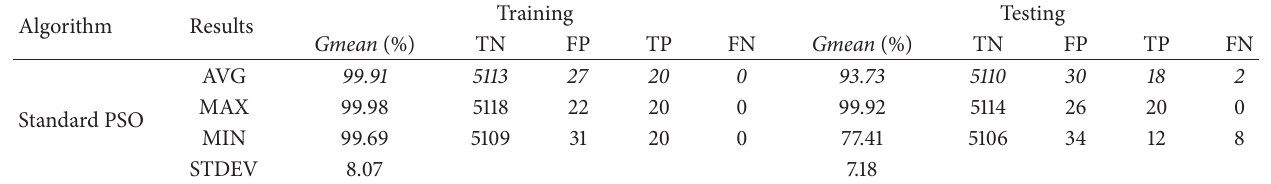
Table 11: Average training and testing results of 10 runs with feature selection using standard PSO. Algorithm